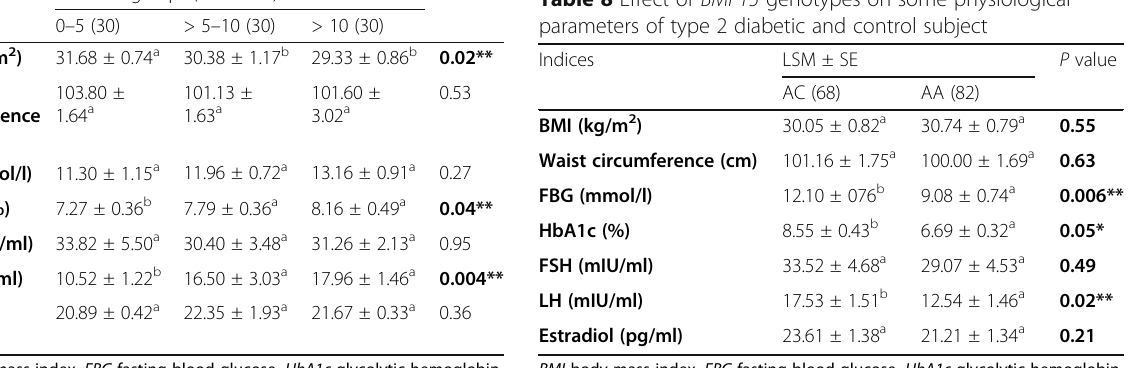
Table 6 Comparison of physiological parameters of type 2 diabetic patients among duration of disease Indices Diabetes groups (LSM ± SE)